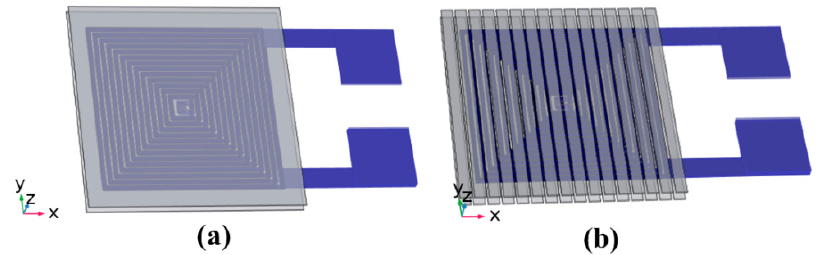
Figure 2. Models of micro-inductors. ( a ) Non-patterned magnetic film; ( b ) patterned magnetic film.